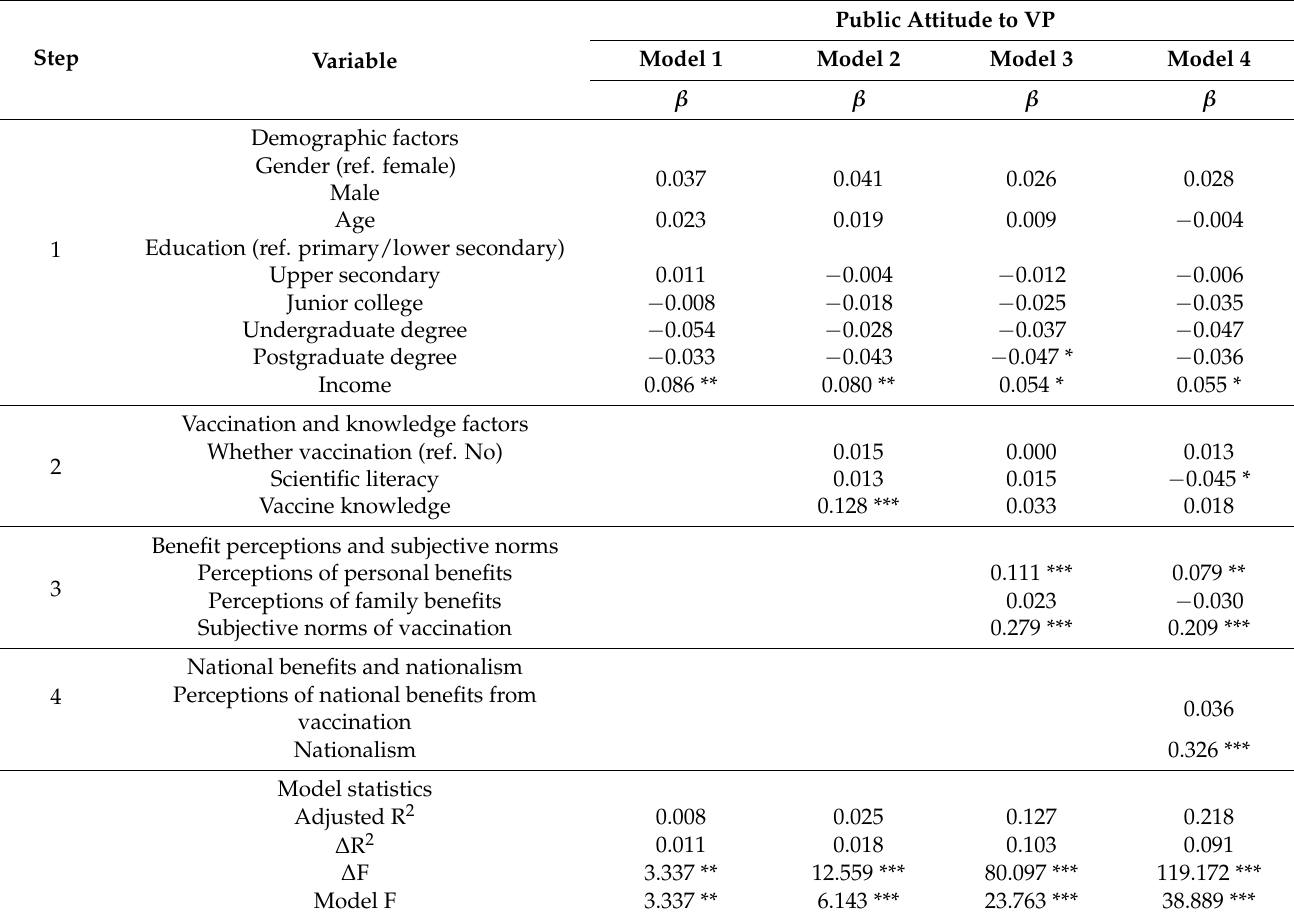
Table 8. Hierarchical regression model of factors associated with attitudes to vaccination passport ( n = 2038).